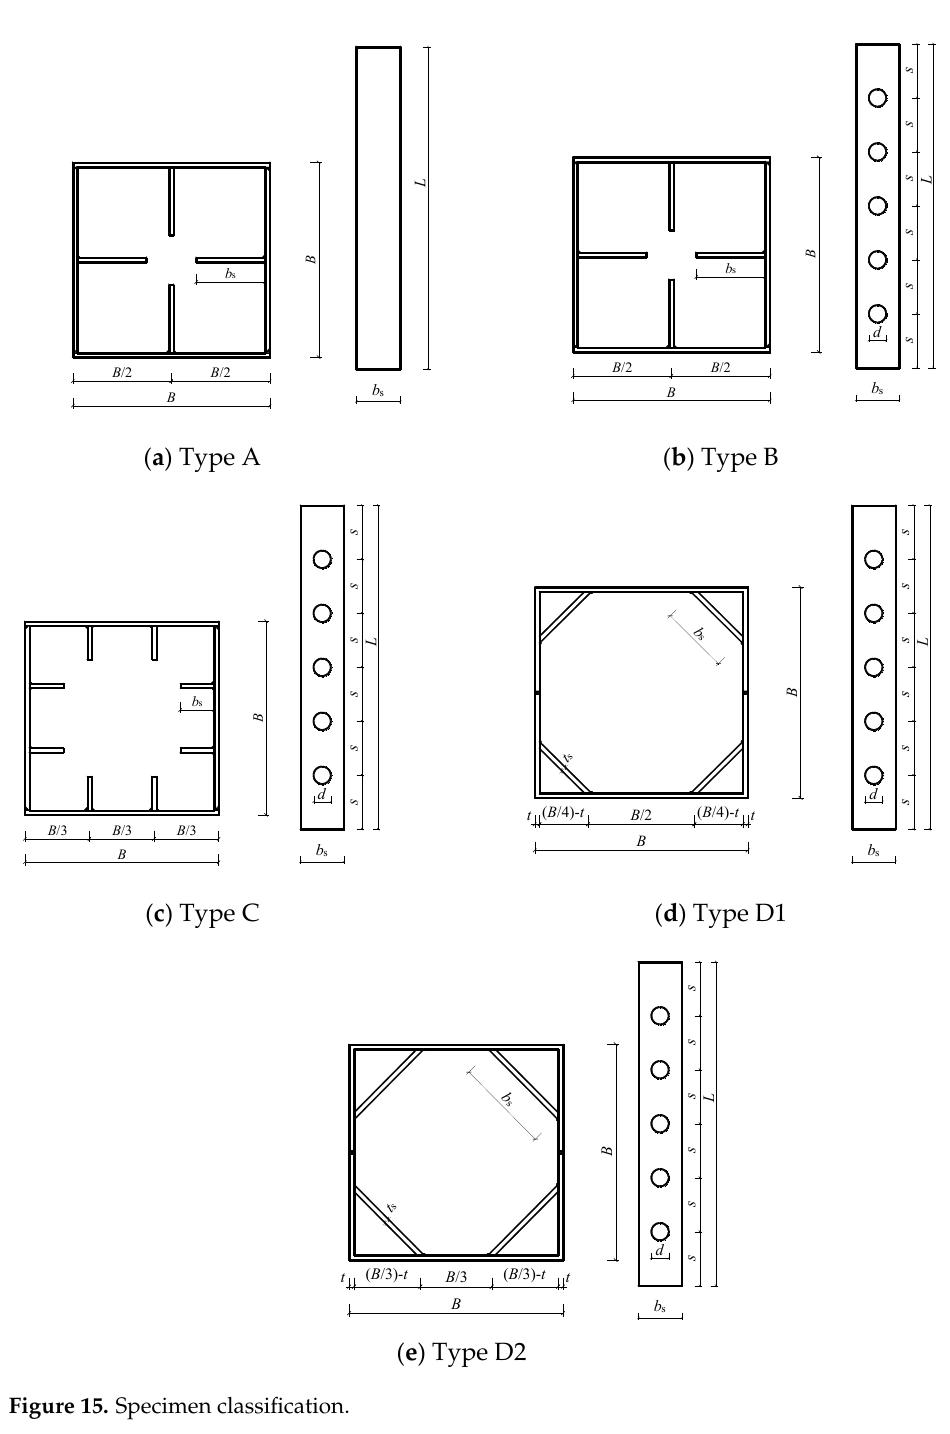
Figure 15. Specimen classification.